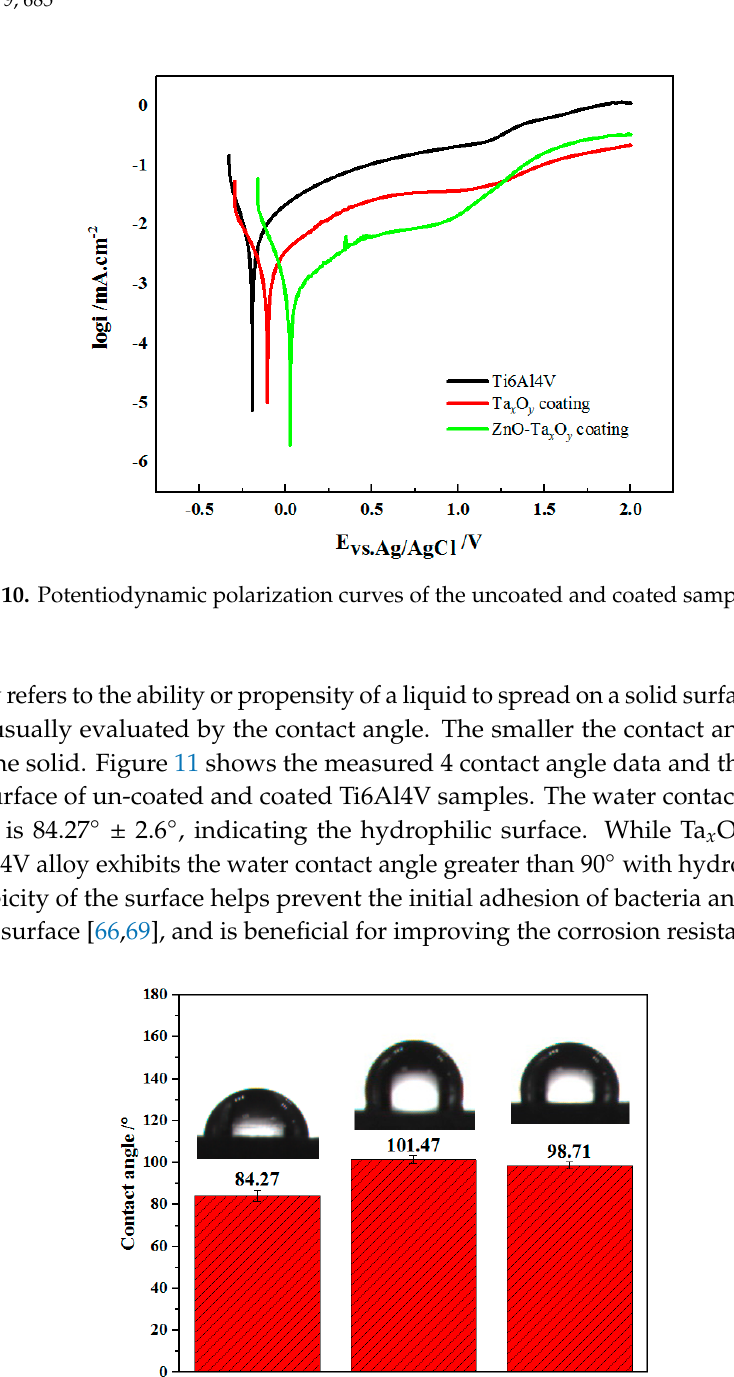
Table 2. Corrosion parameters derived from p olarization curves of Figure 10.